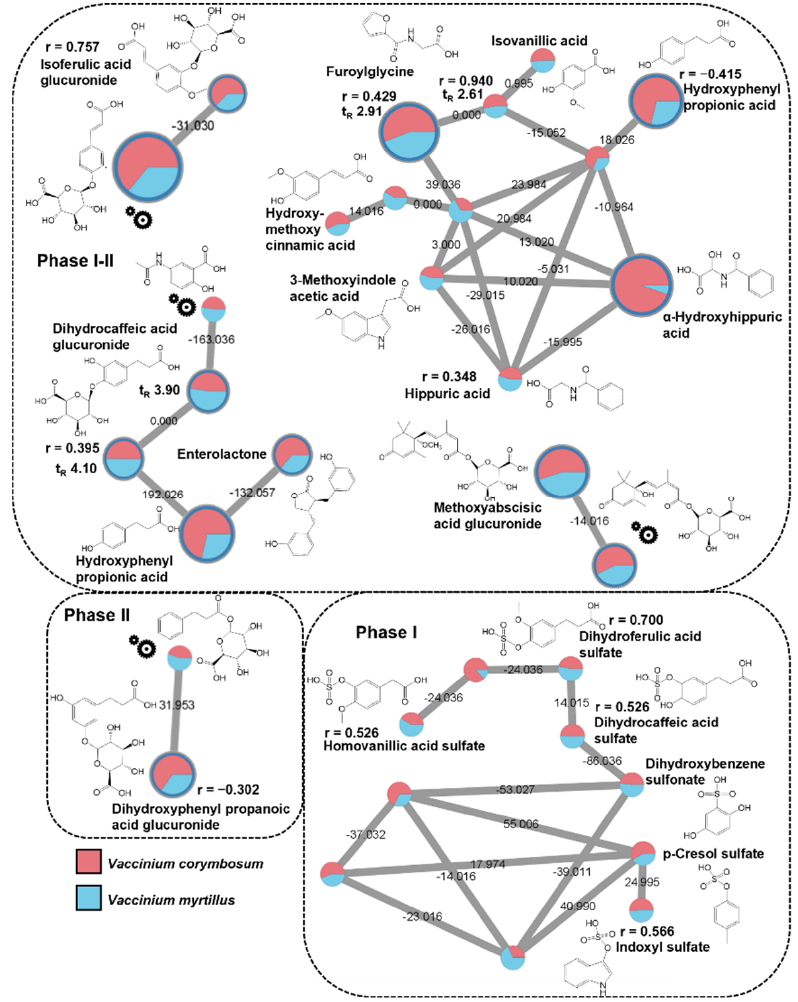
Figure 3. Extracted molecular families of identified metabolites in negative ionization mode listed in Table S2, belonging to the category of (poly)phenolic compounds, abscisic acid, and their glucuronide or sulfate derivatives. Dashed boxes group the identified metabolites according to phase I and II metabolism following PPMC analysis. The “gear” symbols refer to the putative structure identified by manual investigation as reported in Section 2.6 of the main text. Statistically significant Pearson correlation coefficients (r) are reported. Edge labels refer to the mass difference between two nodes.